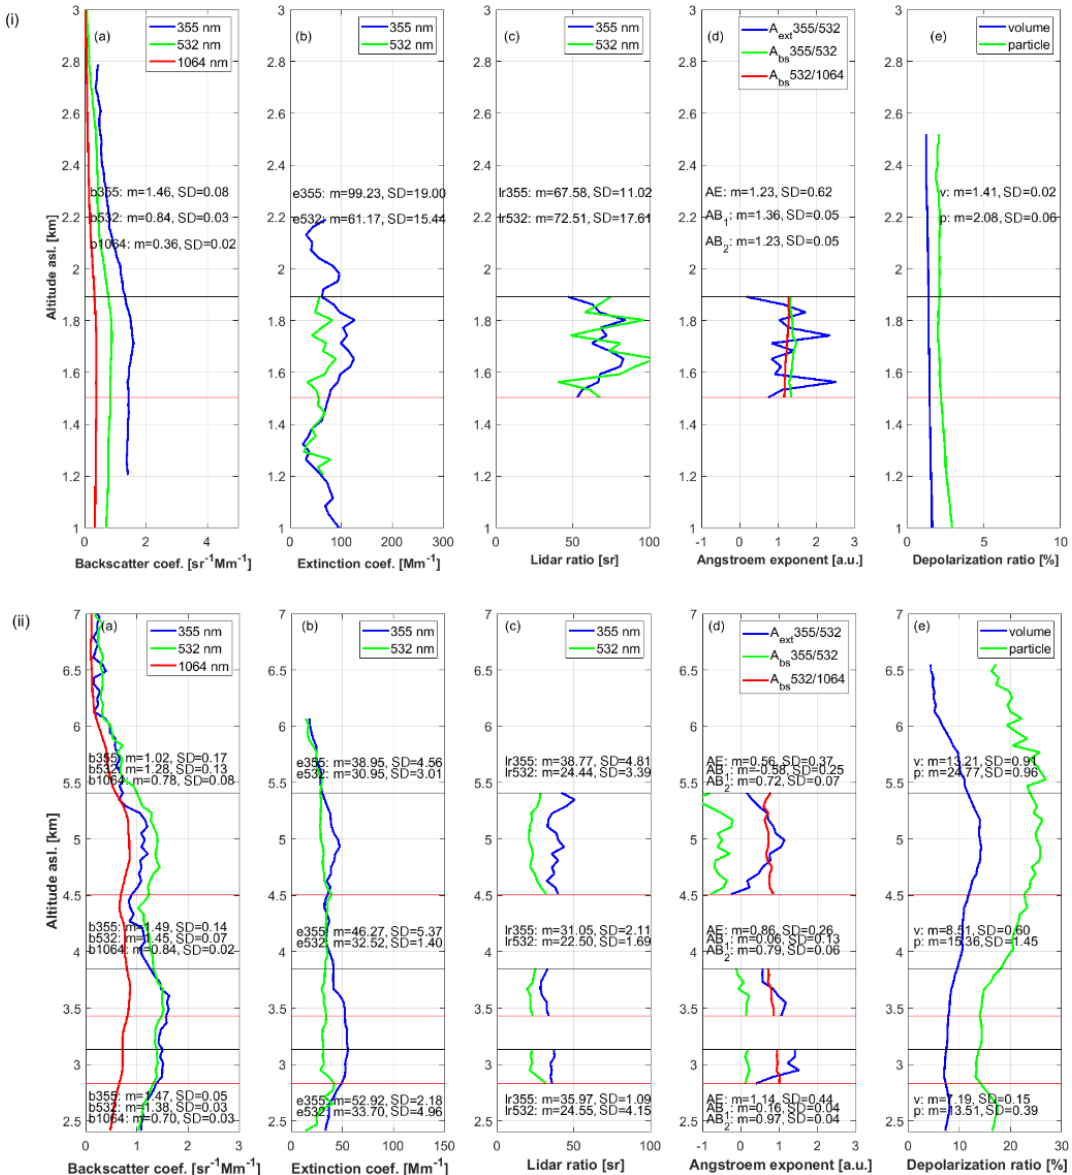
Figure 3. Vertical profiles of the following aerosol optical properties observed over (i) Kuopio (19:25UTC) and (ii) Potenza (21:26UTC) on 30 July 2015, along with their mean values and standard deviations (inserted text): (a) b 355 , b 532 , b 1064 , (b) e 355 , e 532 , (c) LR 355 , LR 532 , (d) A e 355 / 532 , A b 355 / 532 , A b 532 / 1064 , (e) VDR 532 , and PLDR 532